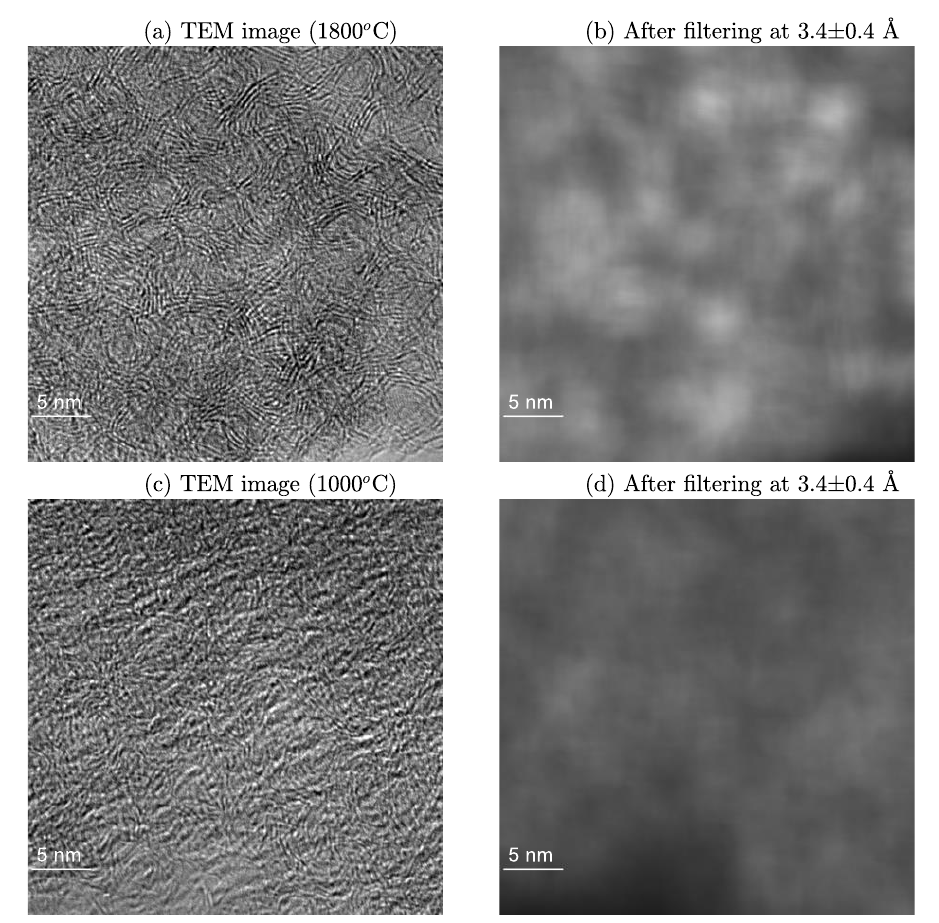
Figure 7. Raw HRTEM images of the cellulose chars ( a ) at 1800 °C, and ( c ) at 1800 °C. ( b , d ): associated filtered images.